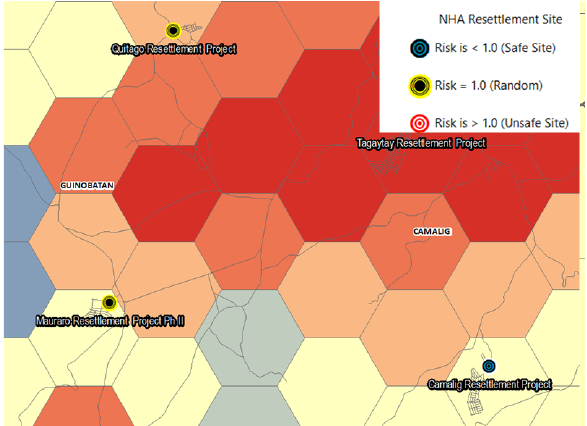
Figure 6. Safe NHA Resettlement and Relocation Sites in Guinobatan Figure 6 reveals the safe resettlement and housing projects of the NHA in Guinobatan.